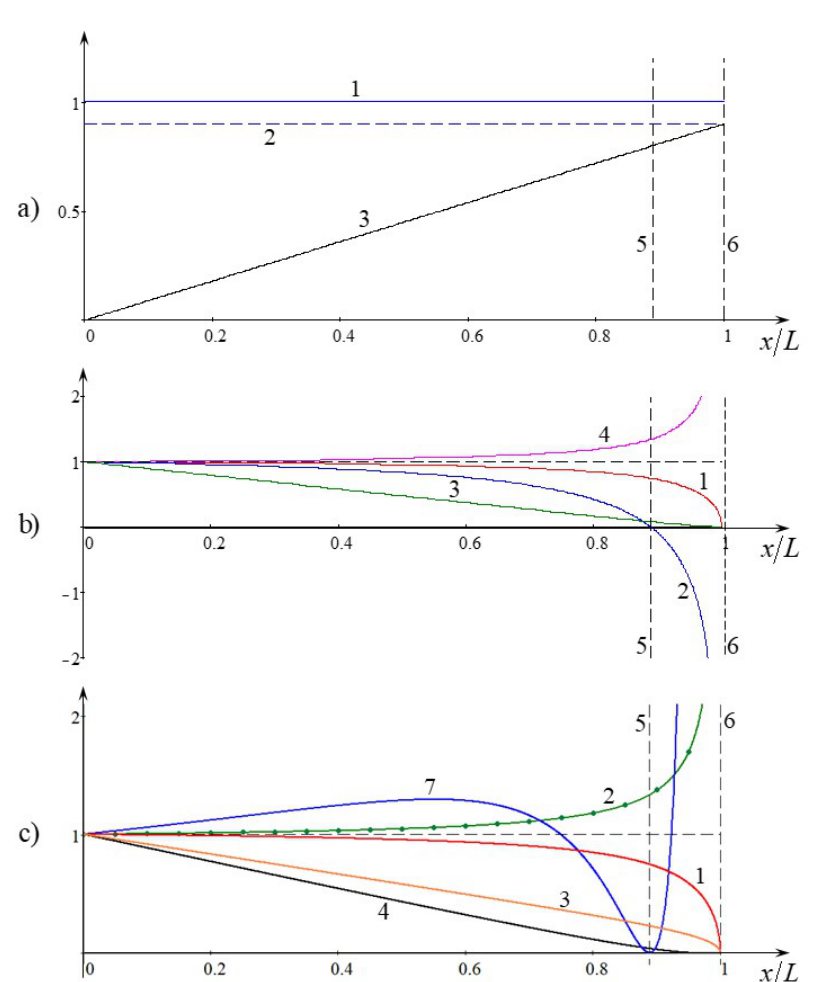
Figure 1. (Color online) Frame ( a ): line 1—free surface in the basin of the total depth H ( 0 ) = 500 m; line 2—position of a pycnocline at the depth h 1 = 50 m; line 3—normalised bottom profile as a function of x / L . Frame ( b ): Normalised coefficients of the time-like Ostrovsky Equation (3): line 1— c ( x ) / c ( 0 ) ; line 2— α ( x ) / α ( 0 ) ; line 3— β ( x ) / β ( 0 ) ; line 4— γ ( x ) / γ ( 0 ) ; line 5—vertical line showing the distance where the upper and lower layers become equal; line 6—vertical line showing the distance where the thickness of the lower layer vanishes. Frame ( c ): Normalised coefficients of the TNLS Equation (7): line 1— c ( x ) / c ( 0 ) ; line 2— k ( x ) / k ( 0 ) ; line 3— c g ( x ) / c g ( 0 ) ; line 4— p ( x ) / p ( 0 ) ; line 7— q ( x ) / q ( 0 )